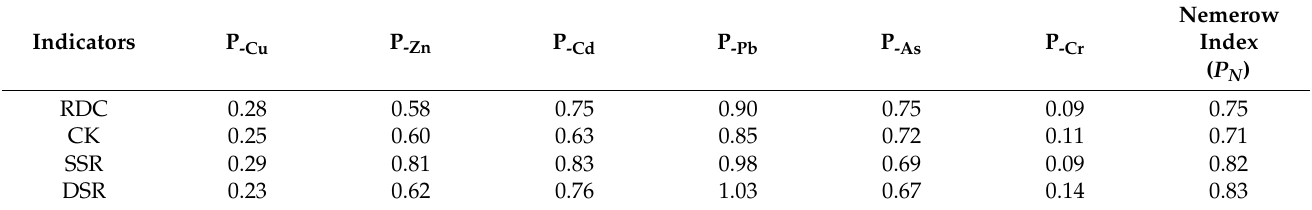
Table 2. Effects of different systems on the Nemerow index ( P N ).